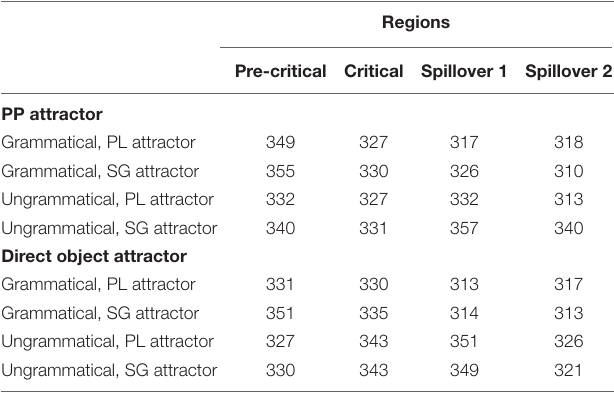
TABLE 2 | Mean reading times (ms) by condition at the regions of interest for Experiment 1.